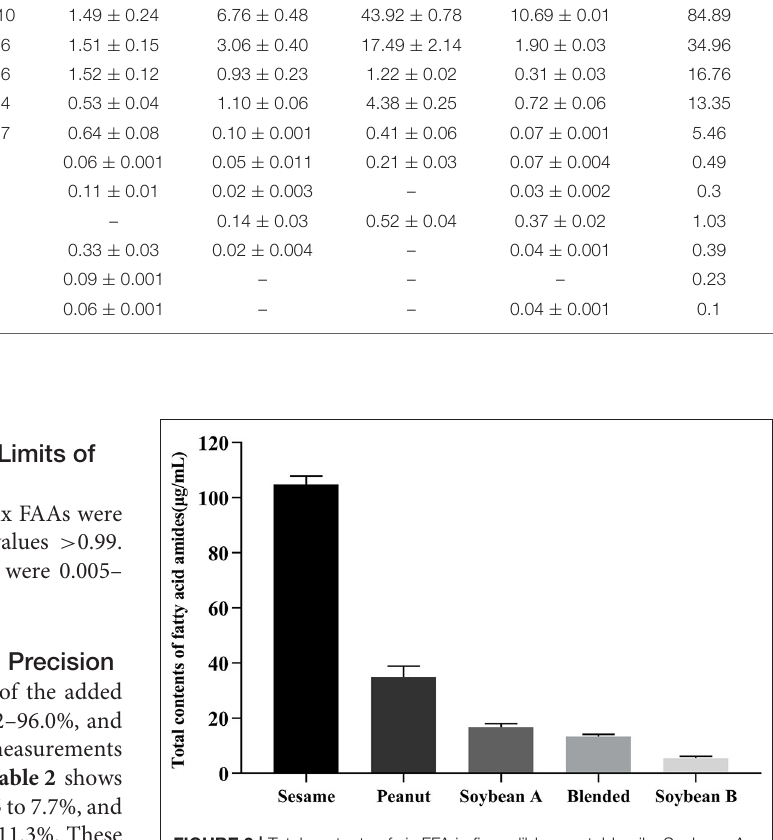
FIGURE 2 | Total contents of six FFA in five edible vegetable oils. Soybean A: non-decolorized; soybean B: